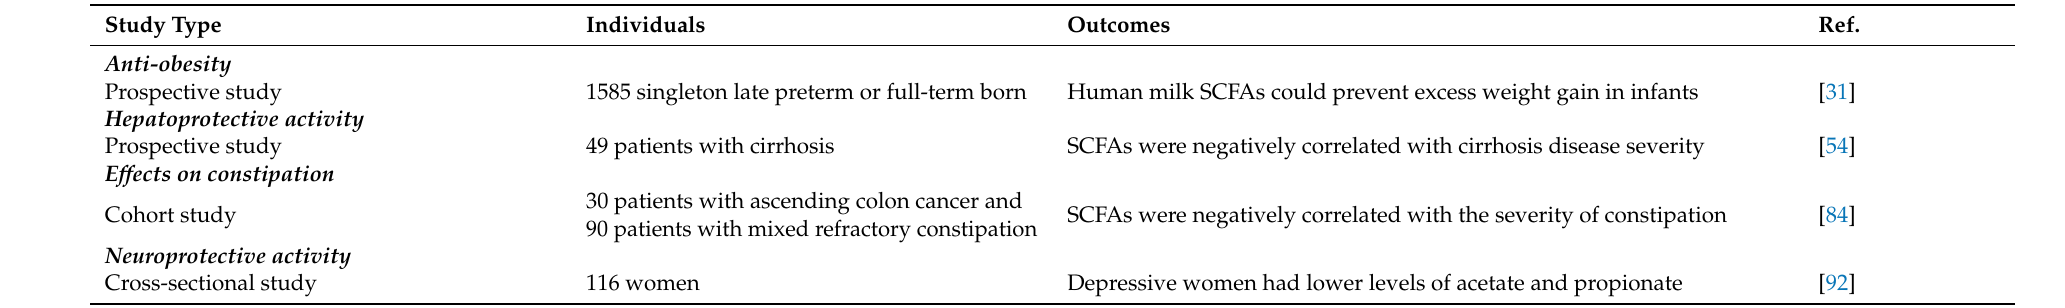
Table 1. Health benefits of SCFAs from epidemiological studies.